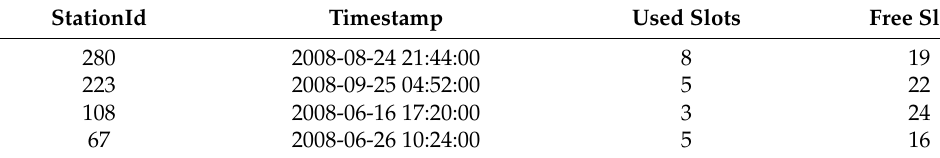
Table 4. Random sample of stations’ status extracted from the dataset. StationId Timestamp Used